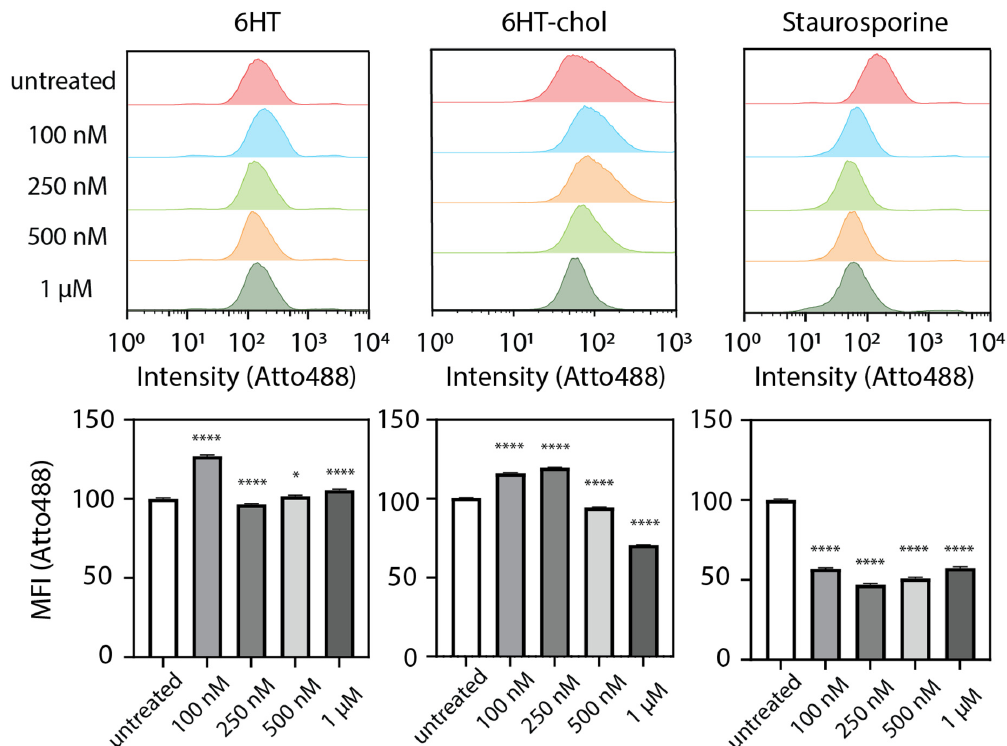
Figure 6. Atto488 efflux upon treatment of HeLa cells with DNA nanotubes. Flow cytometry analysis was performed 3 h after incubation of cells with DNA nanotubes or the apoptosis inducer, staurosporine. The bar graphs below show the mean fluorescence intensity (MFI) normalized to untreated cells. Statistical analysis was performed by an unpaired t -test. * p < 0.05, **** p < 0.0001. n = 3.